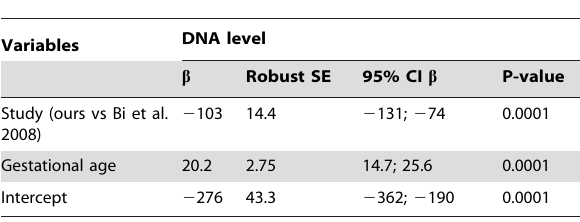
Table 5. Results of multiple linear regression analysis performed to assess the independent relationship between DNA level, the study (ours vs. Bi et al. 2008) and gestational age.